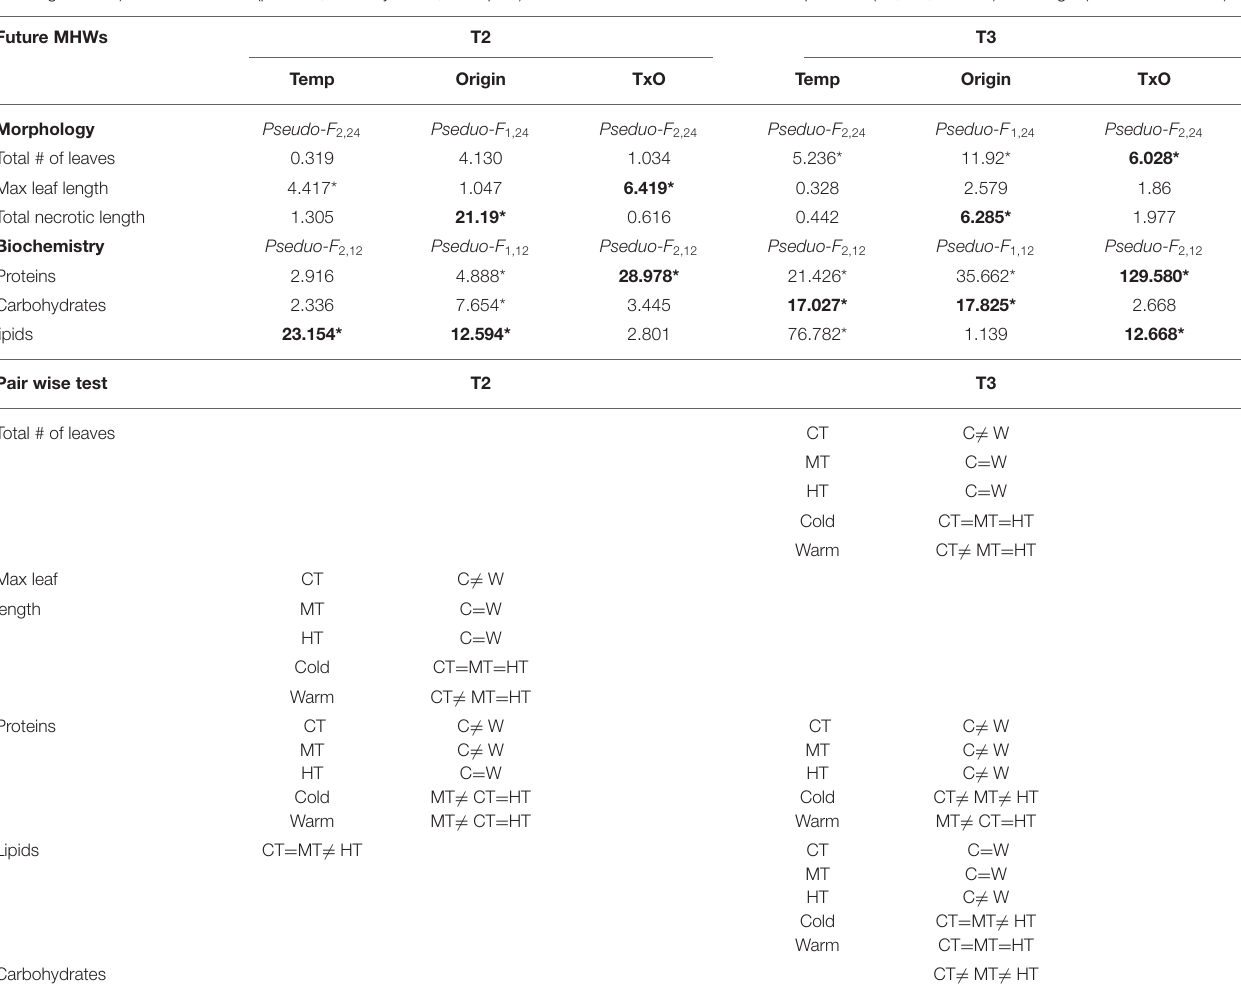
TABLE 5 | Future MHWs: PERMANOVA results on the change at T2 and T3 of the morphological (total # of leaves/shoot, maximum leaf length/shoot and total necrotic leaf length/shoot) and biochemical (proteins, carbohydrates, and lipids) variables due to the effect of the Temperature (HT, MT, and CT) and Origin (cold vs. warm